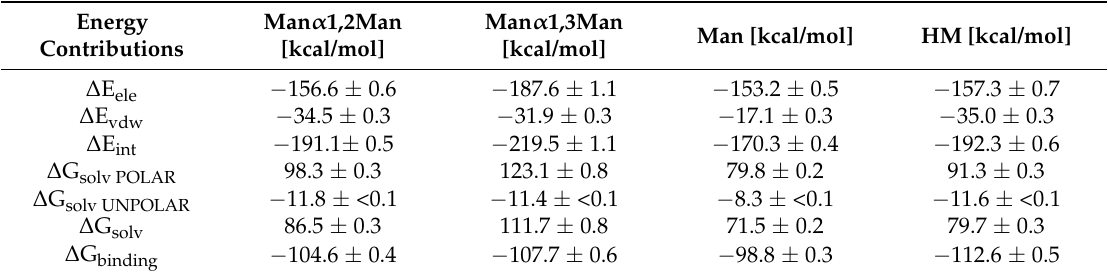
Table 2. Free energies of binding computed by MM-PBSA for different studied mannosides extracted from MD simulations. For more detail, see Section